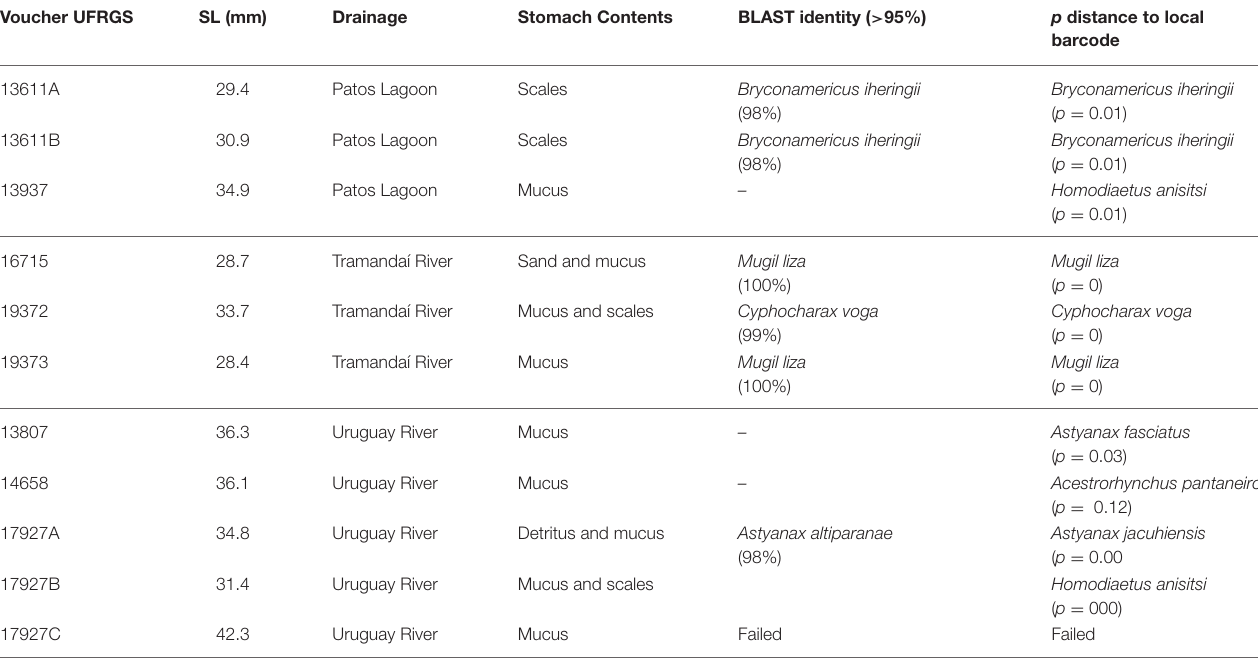
TABLE 1 | Results of the identification of the collected samples from stomach contents of Homodiaetus anisitsi . Voucher UFRGS